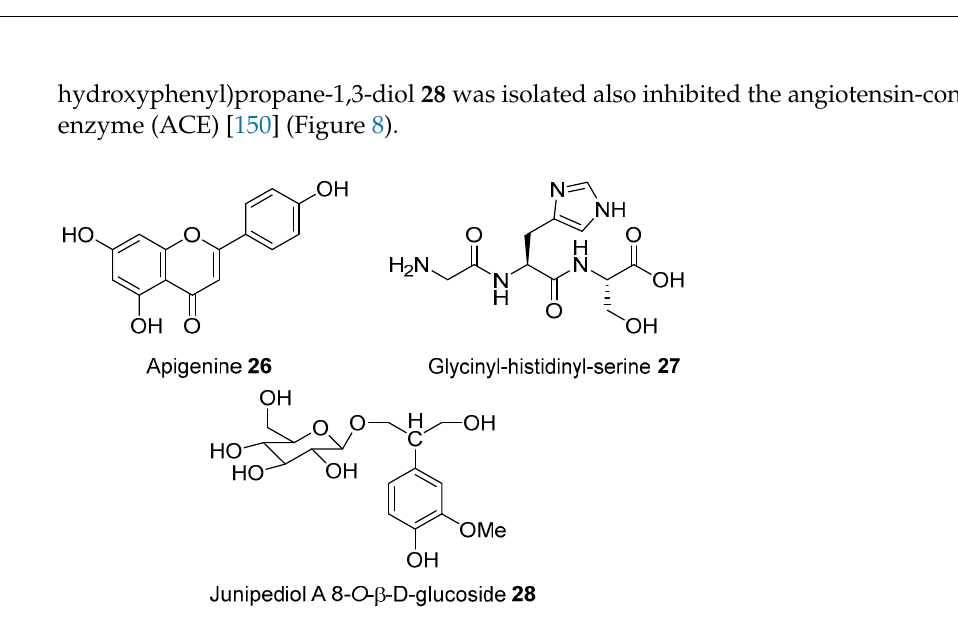
Figure 8. Antihypertensive compounds of plants used by Tenggerese (isolated from same species reported from other countries).